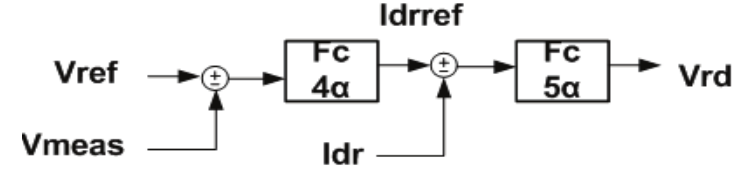
Figure 7. Terminal voltage control of the DFIG for both